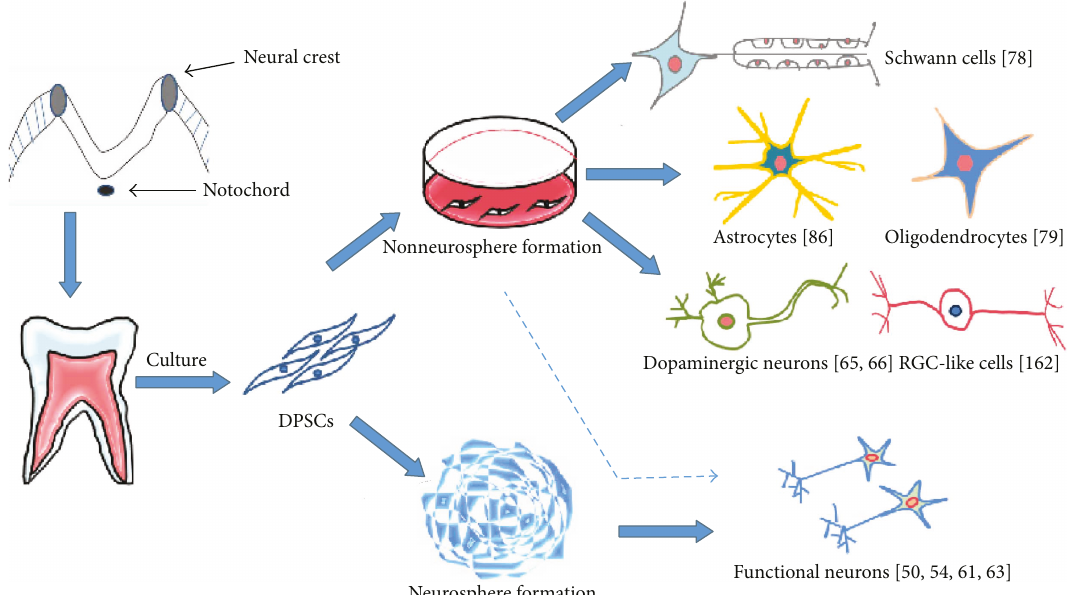
Figure 2: Neural di ff erentiation potential of DPSCs. DPSCs can be induced to di ff erentiate into neural cell lineages including Schwann cells, astrocytes, and dopaminergic